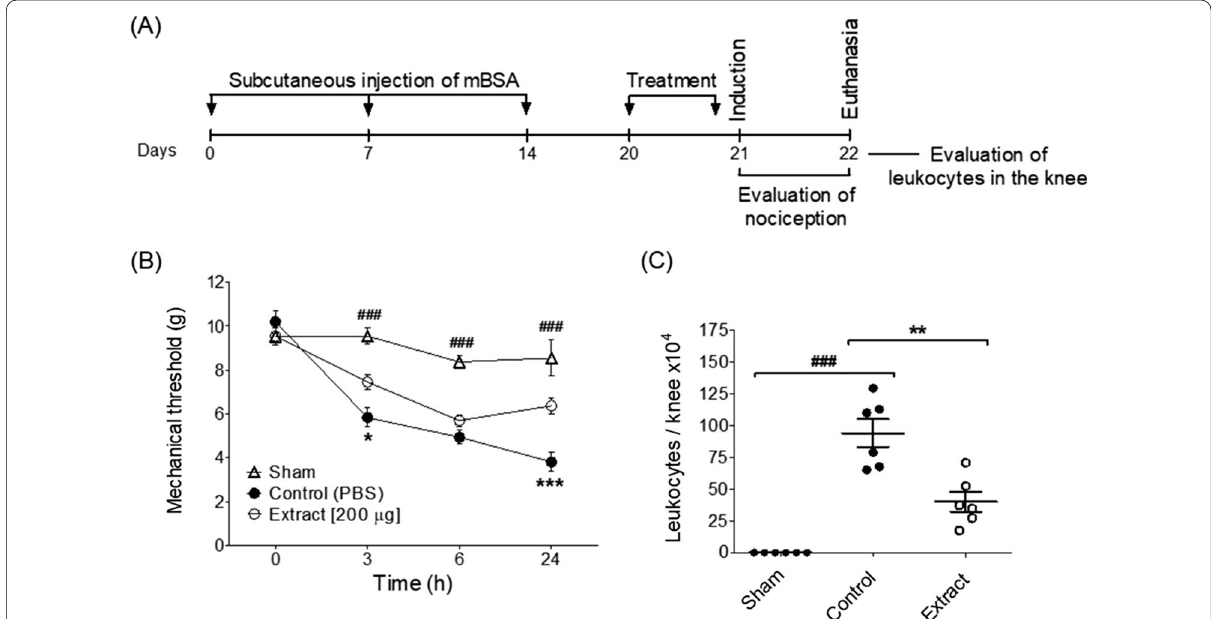
Fig. 5 F. hepatica extract decreased nociception and leukocytes chemotaxis in AIA. A Illustration of experimental design B Nociception was determined at 0, 3, 6 and 24 h after mBSA injection C Counting of leukocytes in the knee of mice 24 h after injection with mBSA. ANOVA followed by Bonferroni post hoc test; Data are expressed as mean